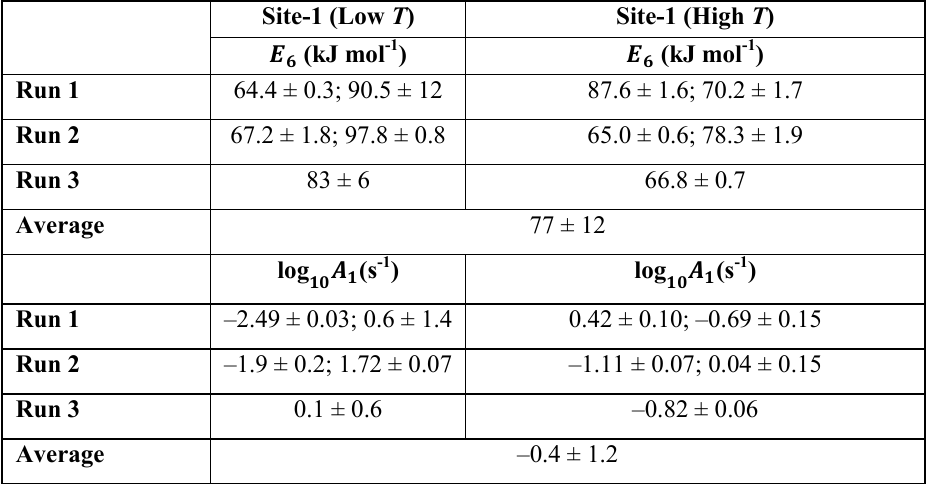
Table 4. Intrinsic isobutene desorption activation energies ( (cid:1831) ) calculated from Equations (15) and (16) for the three runs. Isobutene diffusion ( log (cid:1827) (cid:2869)(cid:2868) (cid:2869) activation energy is (cid:1831) (cid:3404) 56.5 kJ mol − 1 [1] and (cid:1831) (cid:2879)(cid:2873)